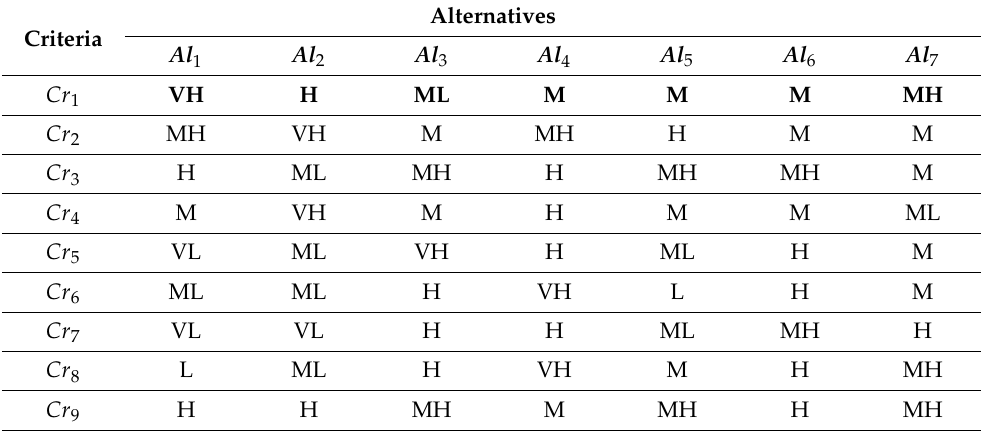
Table 3. Linguistic variables decision matrix from the second DM.